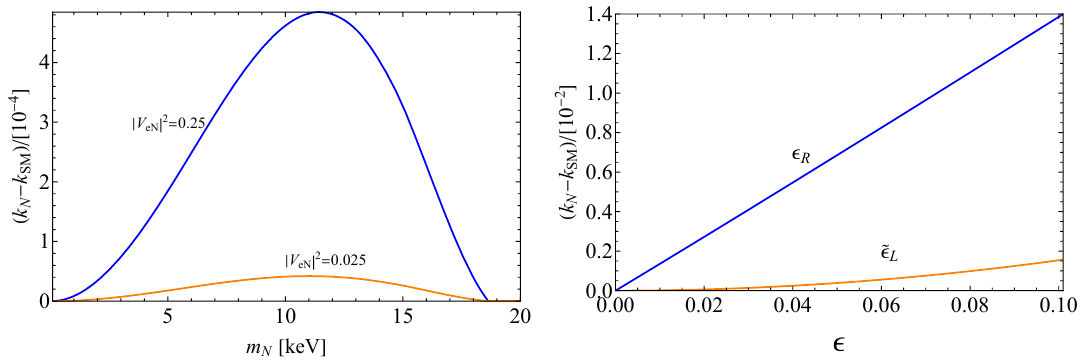
Figure 5 . Deviation of the angular correlation factor k from the SM value k SM as a function of the sterile neutrino mass for different values of the active-sterile mixing parameter V eN (left), and as a function of the exotic couplings (cid:15) R and ˜ (cid:15) L